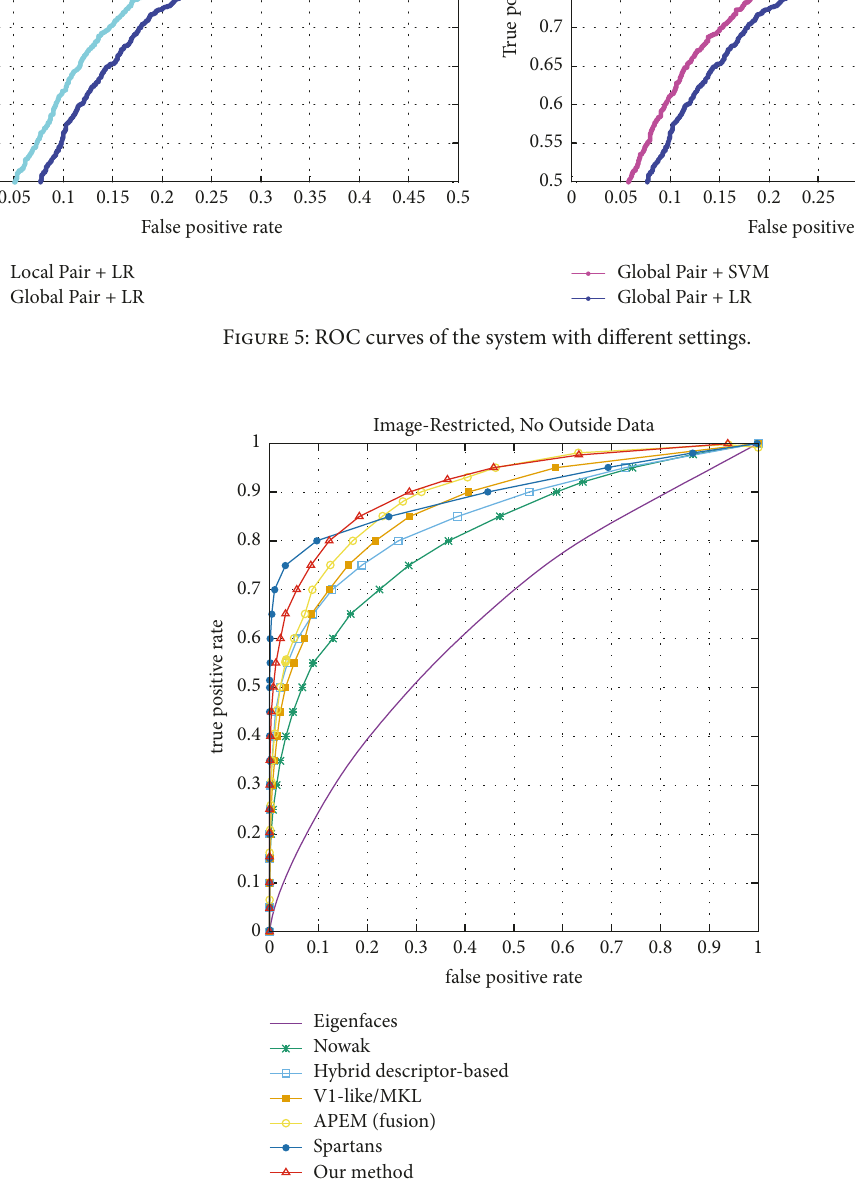
Figure 6: ROC curves of our method and typical techniques in LFW-restricted